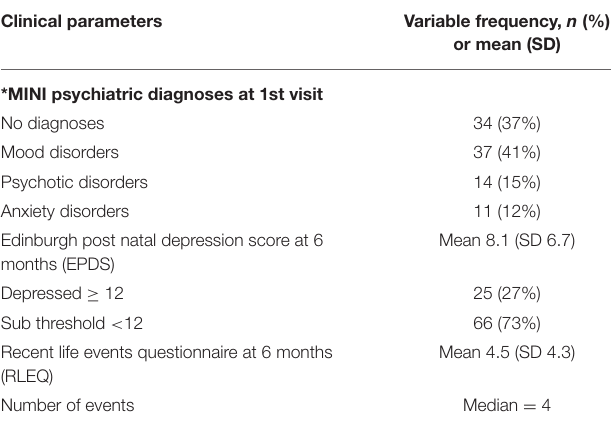
TABLE 2 | Maternal clinical